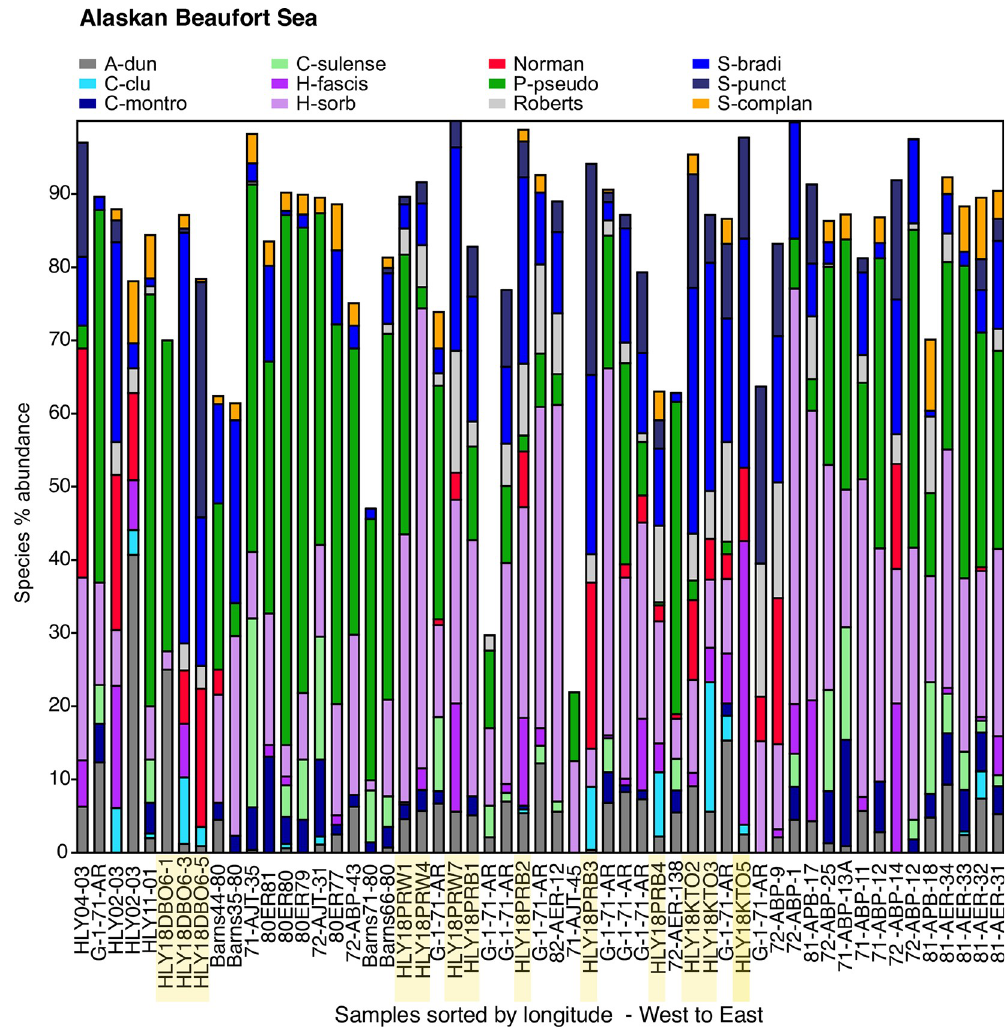
Fig 13. Primary species, Alaskan Beaufort Sea. Stack plot of the 12 most abundant species comprising ~85% of the ostracode assemblage in a narrow band of the Alaskan Beaufort Sea (sites on Fig 4 map) within 100 km of shore at 20-90m water depth from years 1971 to 2018, (n = 55 surface sediment samples with � 30 specimens/sample, 6,617 total specimens). Samples collected in 2018 are highlighted in yellow. Other species not shown on the stack plot that account for 1–2% of